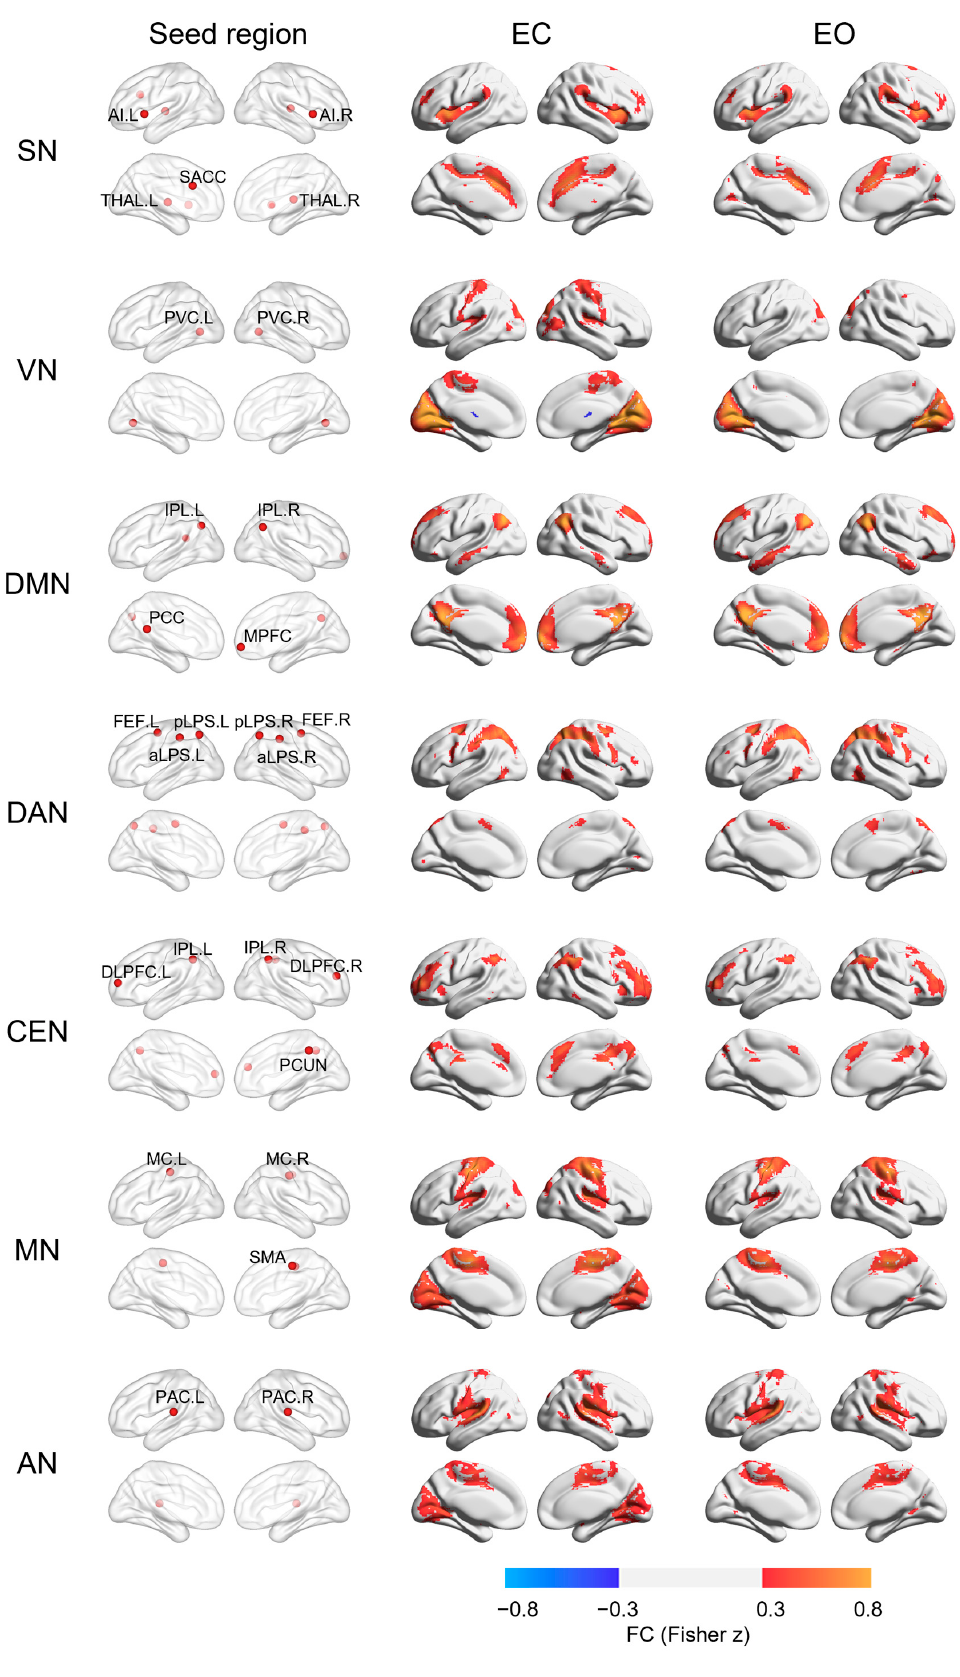
Figure 1. Seed regions of seven networks and their FC maps in EC and EO conditions. The left column shows the seed regions selected for each network. The middle and right column display